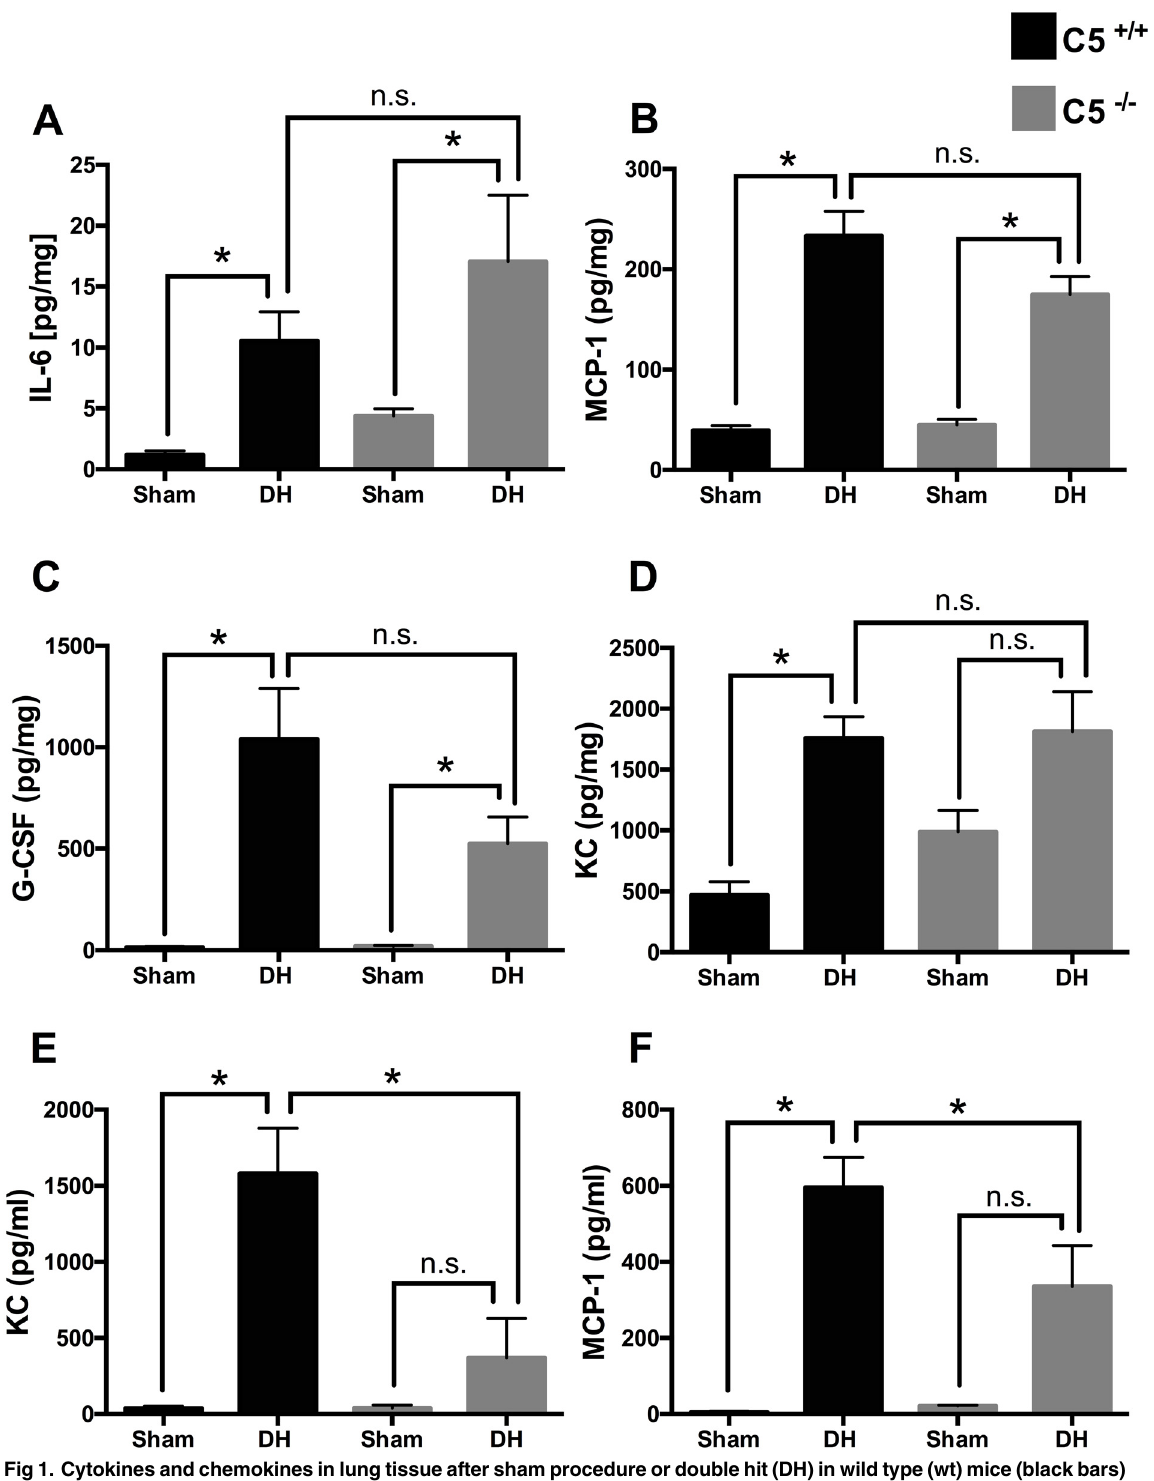
Fig 1. Cytokines and chemokines in lung tissue after sham procedure or double hit (DH) in wild type (wt) mice (black bars) or in absence of C5 (C5 -/- ) mice (grey bars). Systemic effects of the absence of complement C5 in double hit (DH). A . Increased IL-6 levels in lung tissue of wt and in C5 -/- mice after DH compared to sham. B . Increased MCP-1 levels in lung tissue of wt and in C5 -/- after DH compared to sham. C . Increased G-CSF levels in lung tissue of wt and in C5 -/- mice after DH compared to sham. D . Increased KC levels in lung tissue of wt mice. E . Increased KC plasma concentration in wt mice after DH; decreased KC